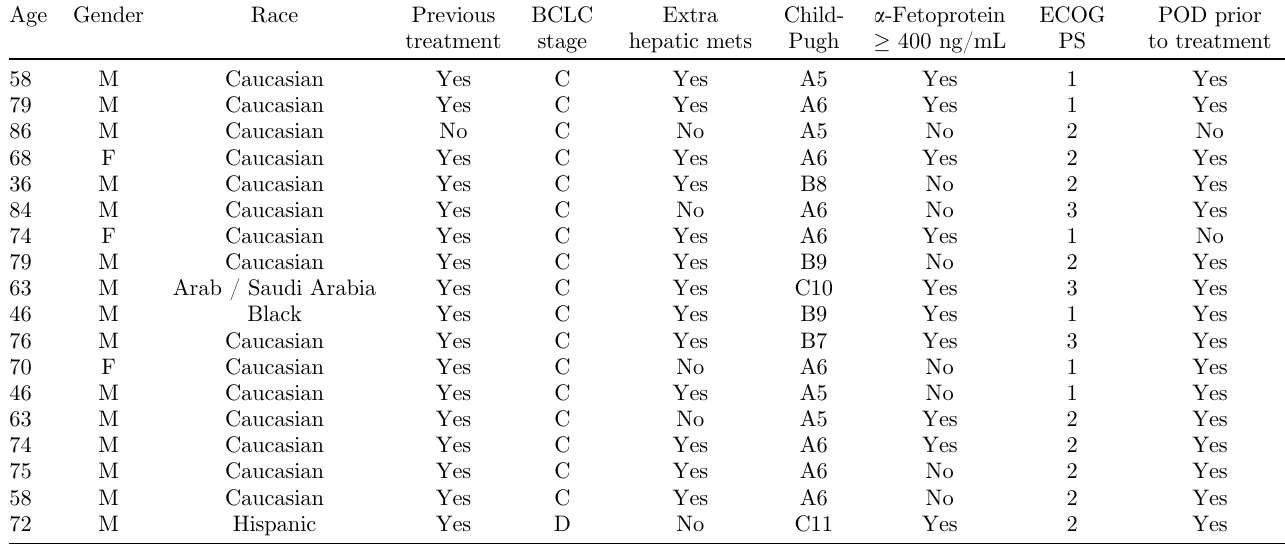
Table 1. Baseline characteristics of real-world patients. Demographics of 18 real-world patients from the TheraBionic registry. All patients had a diagnosis of advanced HCC and received treatment with HCC-speci fi c frequencies.